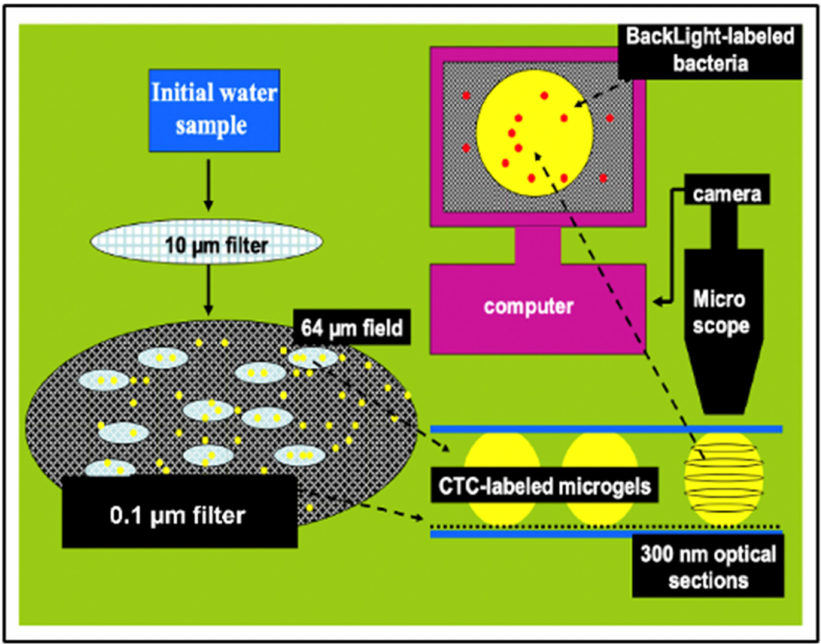
Figure 24. This is an illustration of the method we implemented to count and measure the volume of MG, and count free MB and MB lodged inside MGs. Aliquots of 100 mL of SW are inoculated with: 1 mM sodium azide to arrest bacterial growth; 10 mM BacLigh-Red TM ( λ ex = 581 nm, λ em = 644 nm) to label bacteria; and 100 µ M chlortetracycline (CTC) ( λ ex = 374 nm, λ em = 560 nm) to label MG (Figure 12). SW is first pre-filtered at 15 µ m to retain larger particulate material. The filtrate is then filtered at 10 cm Hg vacuum pressure through a 0.1 µ m black Nucleopore ® filter that retains both MB and MGs. The black filter is then set between two coverslips suspended by 4 µ m microspheres to avoid compressing the MGs. This preparation is then positioned in a Nikon inverted fluorescence microscope with MCR-600 BioRad series laser scanning confocal imaging to perform thin sections tomography of MGs. Counting of both MGs and free bacteria found on top of the filter—outside MG—is conducted in randomly selected fields of ~65 µ m diameter. The average ± SEM counts of free bacteria and gels found in 20 fields are scaled to the total diameter of the filter to report the total of free bacteria and MGs found in the 100 mL aliquot of SW that passed through the filter. Tomographic thin sections of ~300 nm of MGs are imaged at 2000 × magnification and serially sampled at 1 µ m spacing. MG volume is reconstructed by the computer based on the volume of thin sections over the whole serial stack. Bacterial count is performed by tomographic software based on the number of peaks found in 3D plots of contrast ratios of BacLigh-Red TM emission (See Figure 22). In these assays, concentration MB in MG is based on averages ± SEM of counts in 3 to 5 tomographic sections per MG in randomly selected MGs found on five filters per